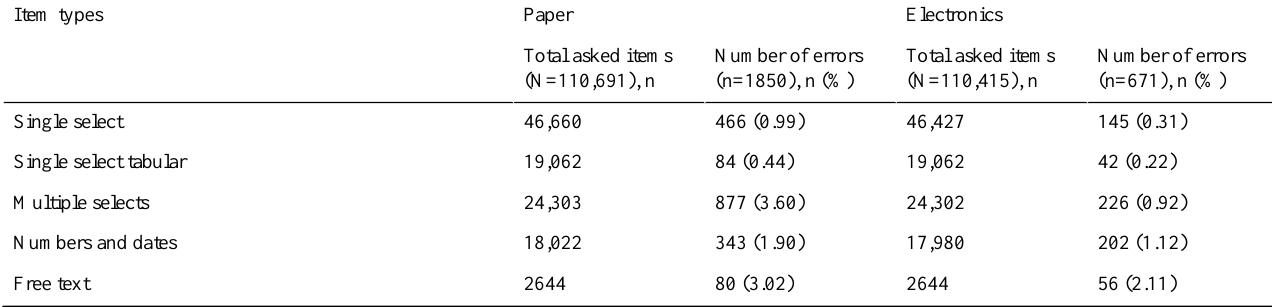
Table 2. Error by item type and the tools used during a survey in a demographic survey site in 2016, in Dabat, northwest Ethiopia. ElectronicsPaperItem